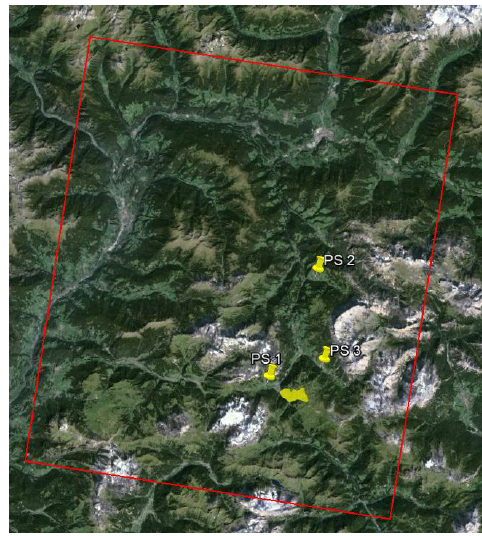
Figure 1. PS’s (PS 1,2,3) distribution and landslide (yellow area) position on the COSMO-SkyMed image